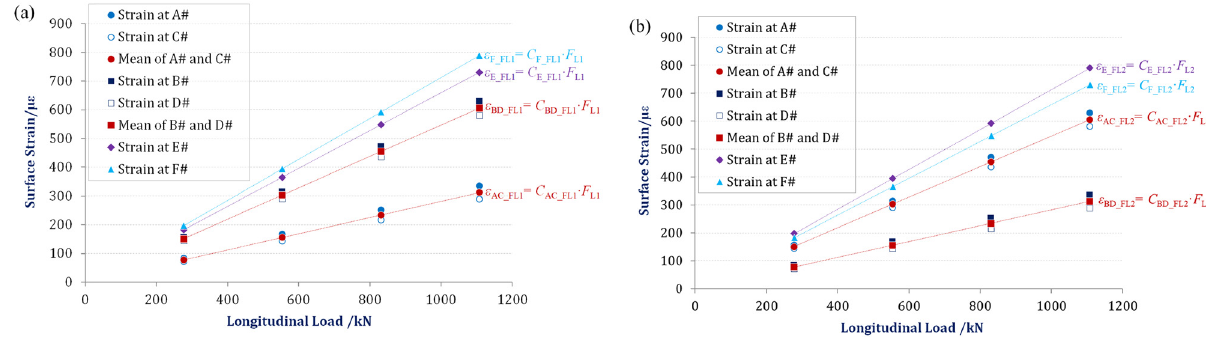
Figure 7: Surface strain response under longitudinal loading at individual jack rod: ( a ) load at jack rod 1# and ( b ) load at jack rod